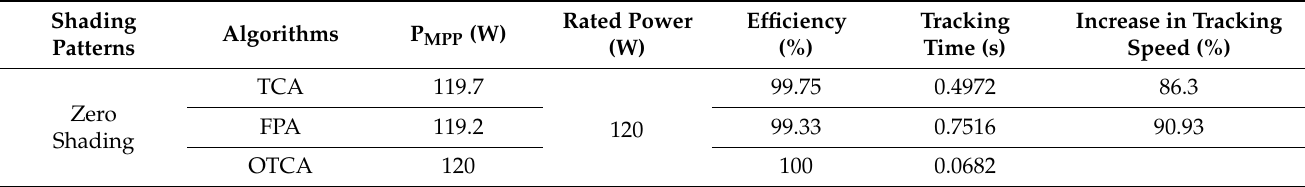
Figure 6. Results for FPA, TCA, and OTCA under zero shading. ( a ) FPA ; ( b ) ten check algorithm ; ( c ) optimized ten check algorithm . Table 3. Performance comparison of FPA, TCA and OTCA under zero shading.